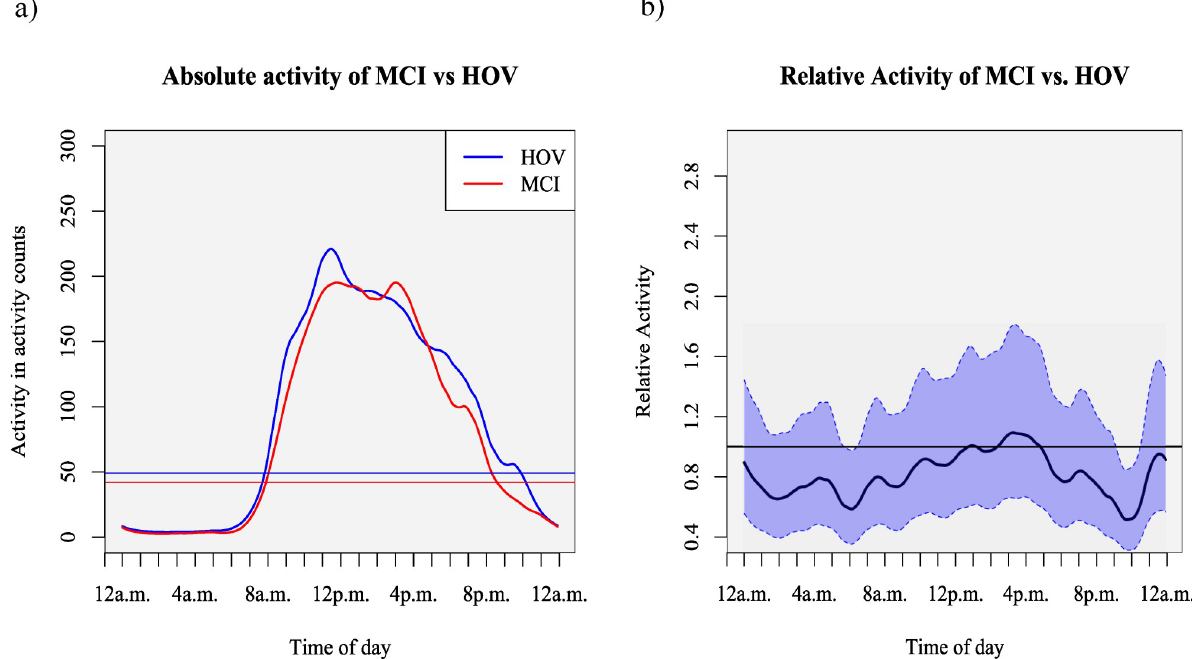
Fig 1. Comparison of absolute and relative activity distribution between MCI and HOV. Distribution of a) mean absolute activity between MCI and HOV over time and b) mean relative activity between MCI and HOV over time with 95% Confidence Interval (CI) adjusted for age. Horizontal lines in Fig 1A) displays the average daily activity of log-transformed data from fitted curves of respective groups. The black line in Fig 1B) displays a relative activity. A value of one indicates no difference of activity between the two groups.